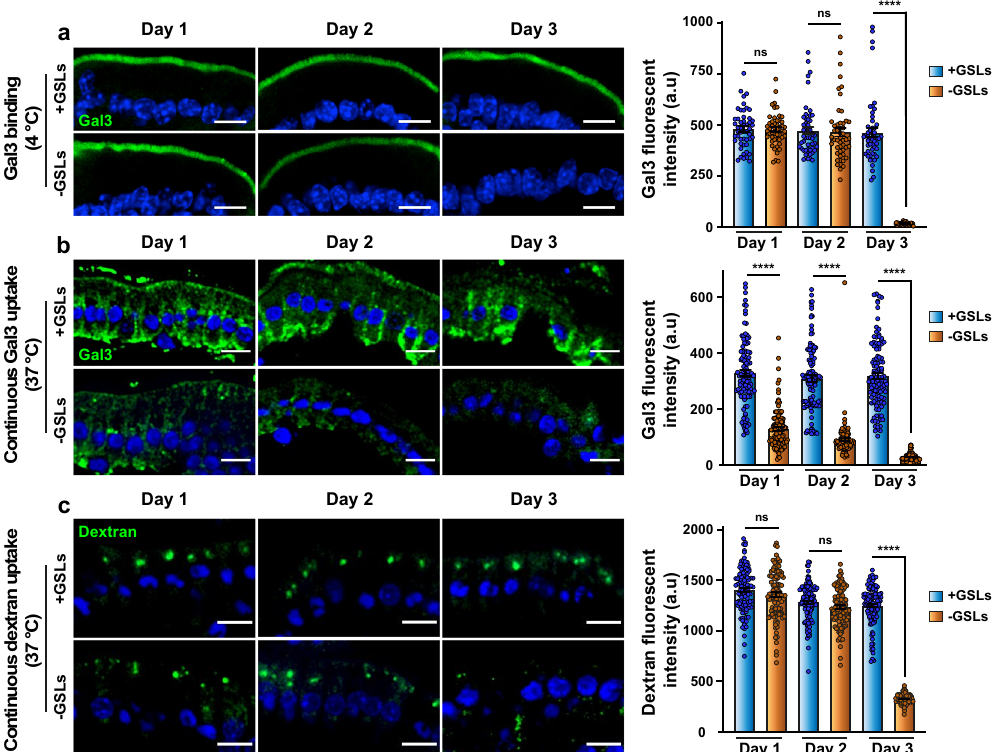
Fig. 5 Gal3 undergoes GSL-dependent endocytosis. a DTT-treated jejunum of TAM-injected Ugcg fl ox/Cre + (-GSLs) or Ugcg fl ox/Cre - ( + GLSs) mice was incubated at 4 °C with 20 µ g/mL of Gal3 (green). Note that Gal3 binding to the apical surface was similar at days 1 and 2 after TAM injection, while it dropped to background levels at day 3. Right: Quanti fi cation of apical signal (means ± SEM, n = 50 cells analyzed per condition, one representative of four independent experiments). b Experiment as in ( a ), except that incubation with Gal3 (green) was done for 30 min at 37 °C. Cell surface-exposed Gal3 was removed with lactose wash. Note that Gal3 uptake was strongly inhibited in GSL-depleted enterocytes, starting with day 1. Right: Signal quanti fi cation (means ± SEM, n = 114 cells per condition, one representative of four independent experiments). c Experiment as in ( b ), except that incubation at 37 °C was performed with 1 mg/mL of 40-kDa dextran (green). Dextran uptake was similar at days 1 and 2 after TAM injection, while it dropped to background levels at day 3. Right: Representative signal quanti fi cation (means ± SEM, n = 109 cells per condition, one representative of four independent